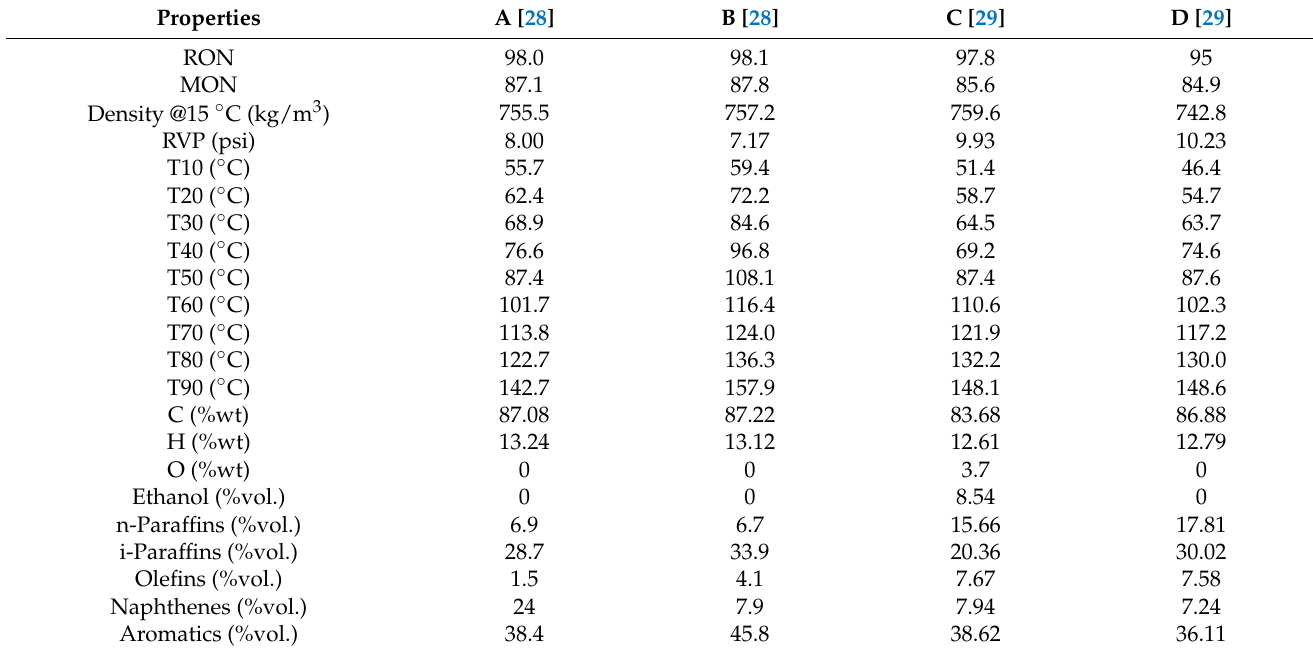
Table A1. Main available useful properties of the validation gasolines, collected from literature.